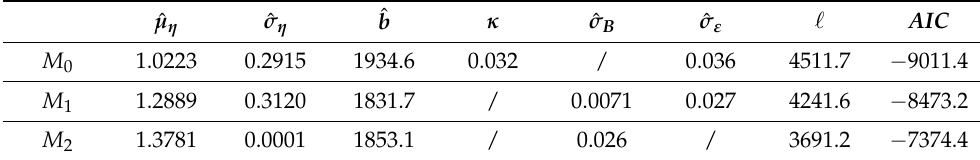
Figure 1. The degradation trajectory of LEDs under CSADT over time t at ( a ) 25 °C, ( b ) 65 °C, ( c ) 105 °C. Table 2. Comparisons of three different degradation models with LEDs CSADT degradation data.